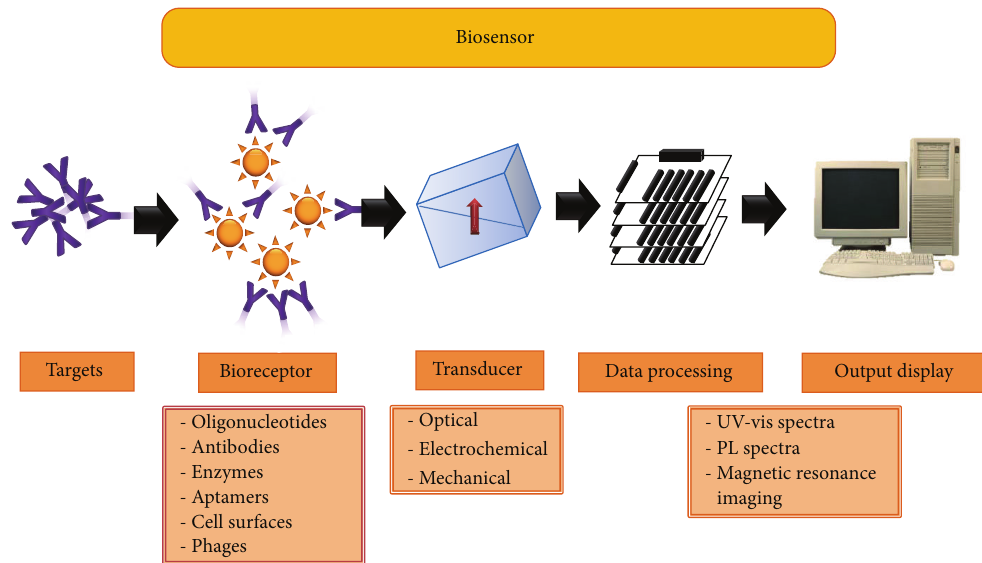
Figure 2: Scheme representing nanobiosensor components consisting of different bioreceptors (e.g., antibodies, aptamers, cell-surface molecules, enzymes, oligonucleotide probes, and phages) and major transducers depending on types of signal response (i.e., optical, electrochemical, and mechanical signal). Output can be displayed as UV-visible or photoluminescence spectra and magnetic resonance